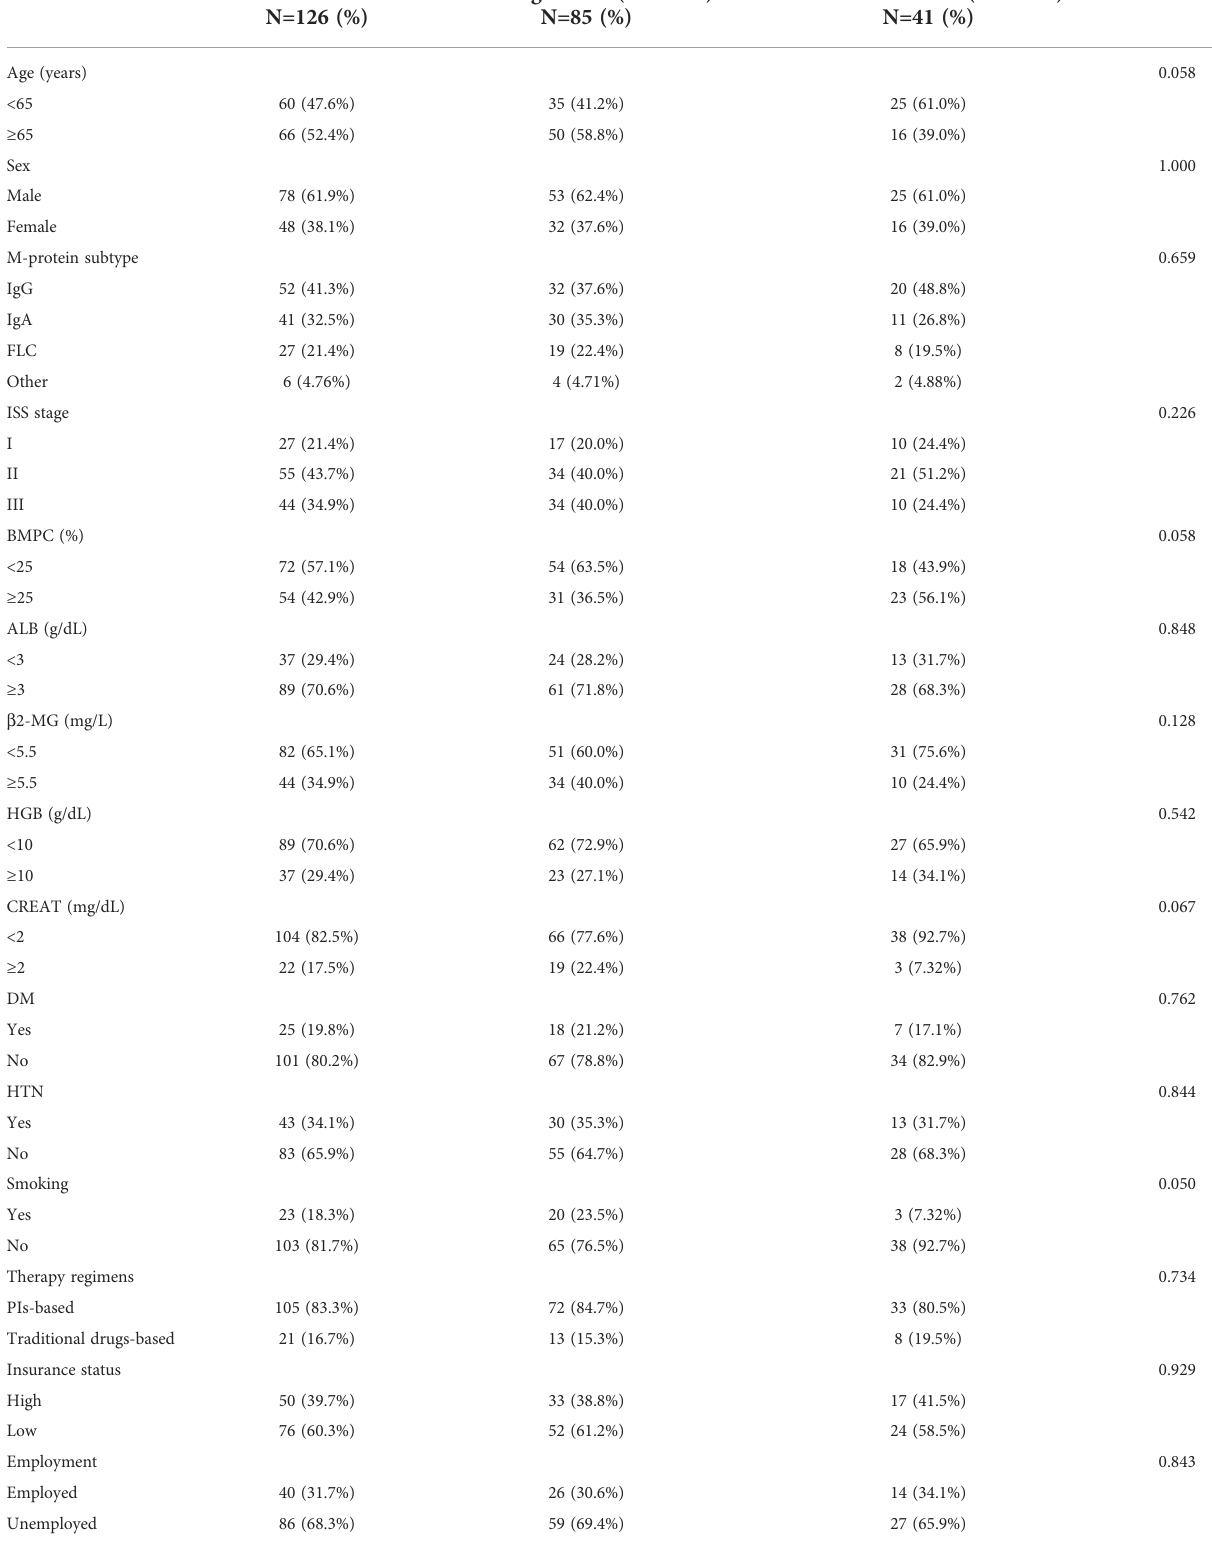
TABLE 4 Baseline clinical and sociodemographic characteristics of MM patients in the two-center